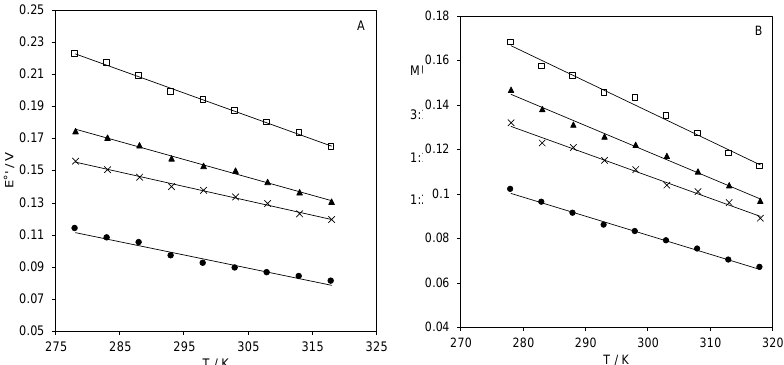
Figure 5. E ◦(cid:48) vs. T plots of Streptomyces coelicolor small laccase (SLAC) immobilized on a gold electrode coated with electrostatically ( A ) MUA ( • ), 3:1 MUA/MU ( × ), 1:1 MUA/MU ( (cid:78) ), 1:2 MUA/MU ( (cid:3) ), or covalently ( B ) MUA(EDC/NHS) ( • ), 3:1 MUA/MU (EDC/NHS) ( × ), 1:1 MUA/MU (EDC/NHS) ( (cid:78) ), 1:2 MUA/MU (EDC/NHS) ( (cid:3) ), respectively. pH = 7.0. Reduction entropy ( ∆ S ◦(cid:48) ) is calculated from the slope of the linear regression lines. The error bars are not shown because they have the same dimension of the symbols.